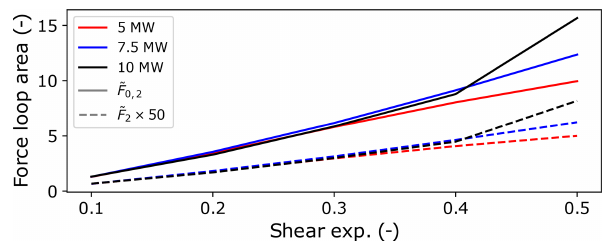
Figure C3. Non-dimensionalised, downwind-row, radial load-loop- area results for various shear exponents for overhung ( ˜ F 0 , 2 ) and centred ( ˜ F 2 ) support main-bearing configurations across the three modelled turbines.